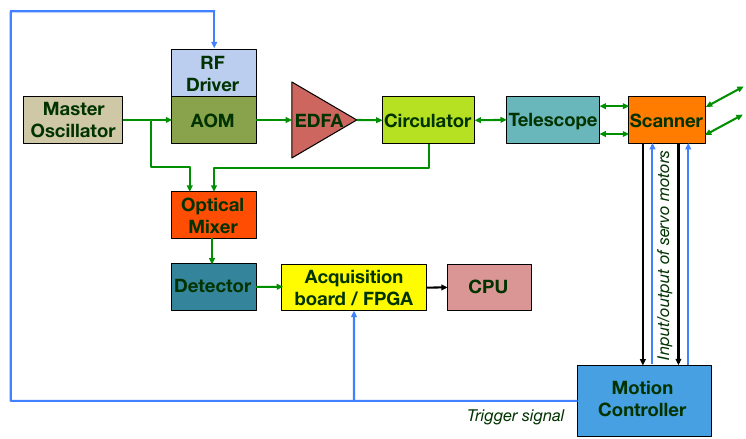
Figure 2. The long-range WindScanner block diagram. Green, blue and black arrow lines represent light, electrical and digital signals, respectively.